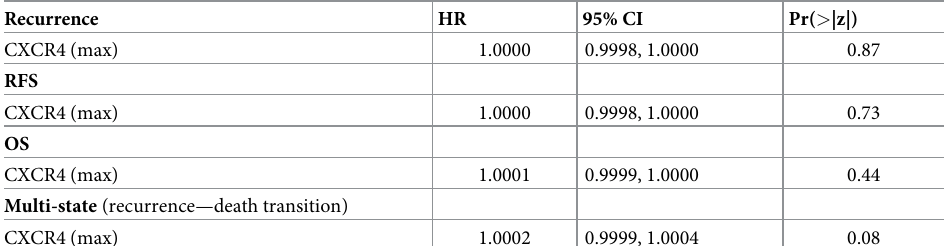
Table 3. Impact of CXCR4 expression on recurrence, RFS and